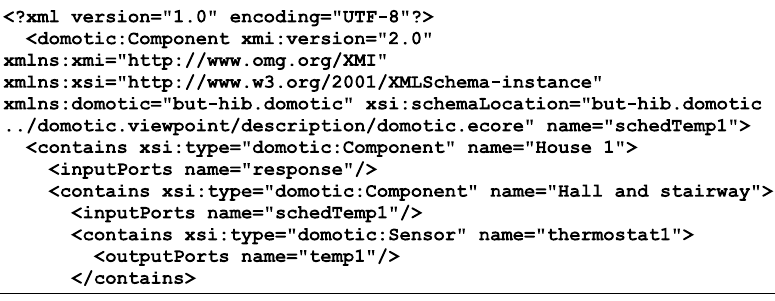
Fig. 2. The input model (a part) in EMF